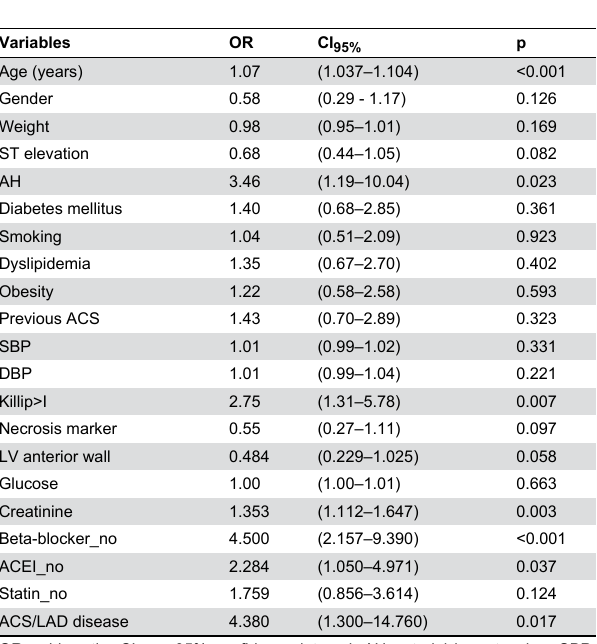
Table 4. Univariate regression analysis for death at6